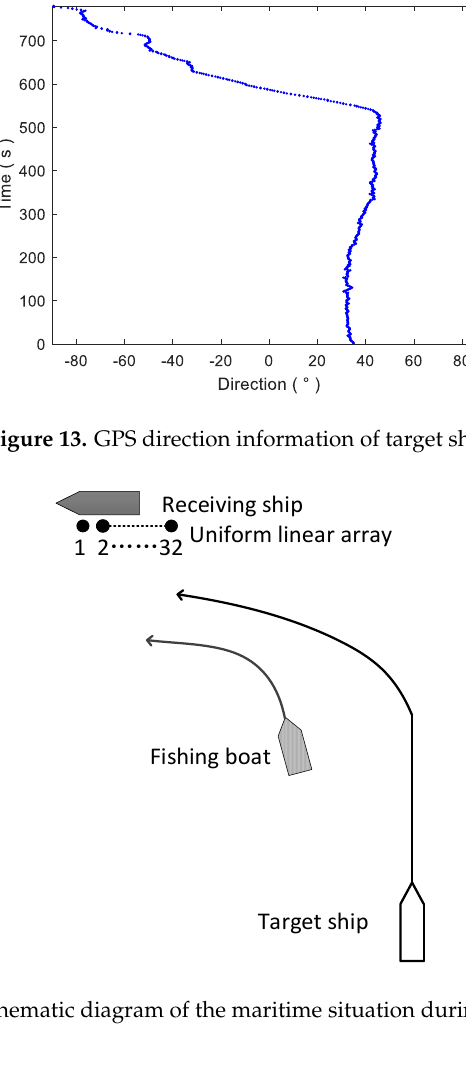
Figure 12. The general distribution of self-radiated noise from the receiving ship.